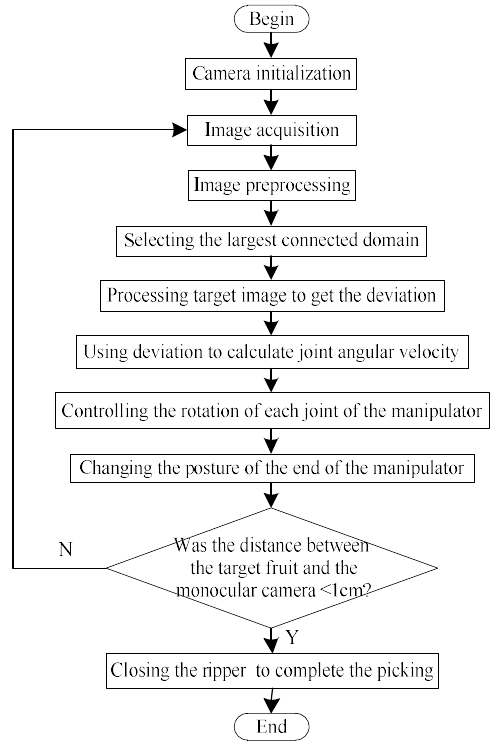
Figure 17. Process of monocular visual servo.